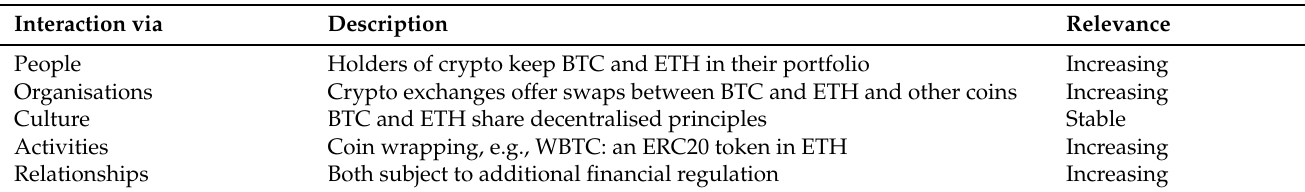
Table 5. Network-centricity in public blockchain